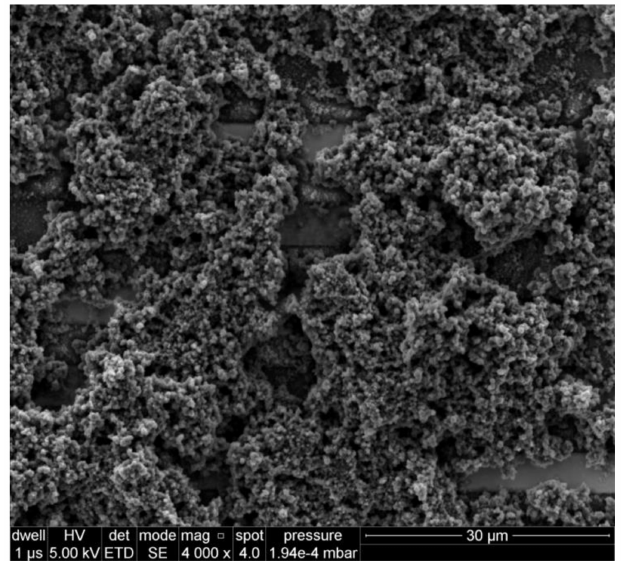
Figure 1. SEM image of PCz deposited on IDE-Pt using 10 polymerisation cycles.